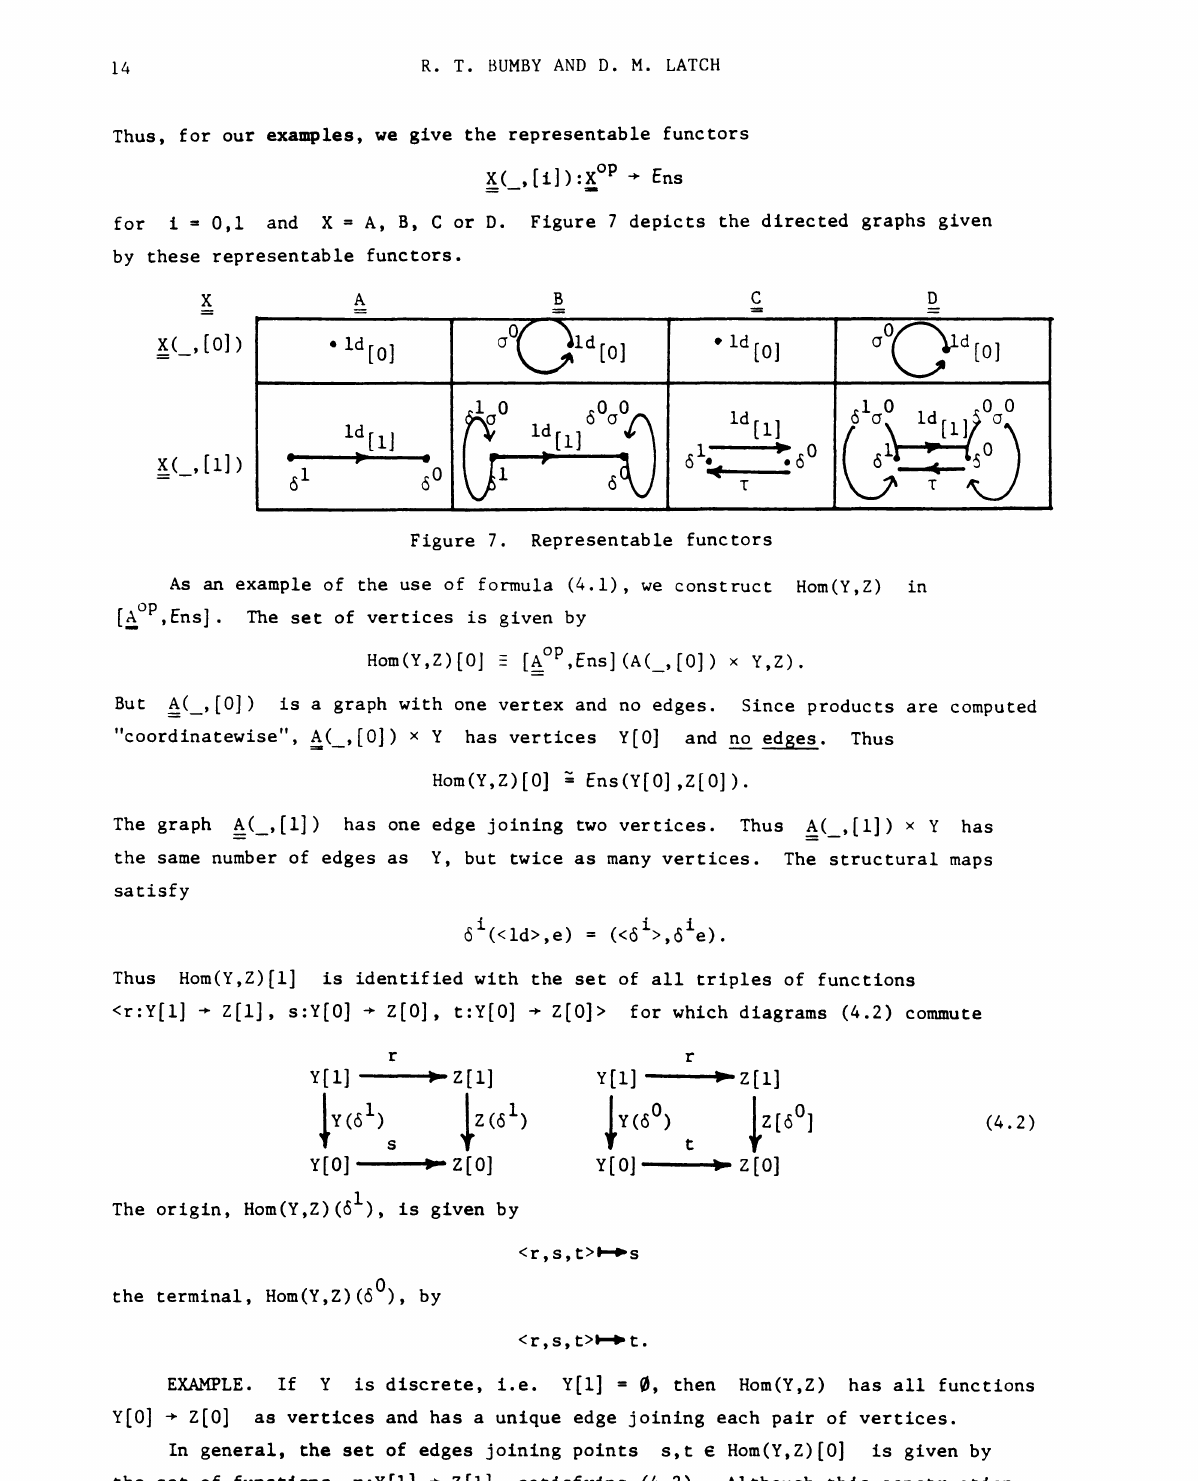
Figure depicts the directed graphs given